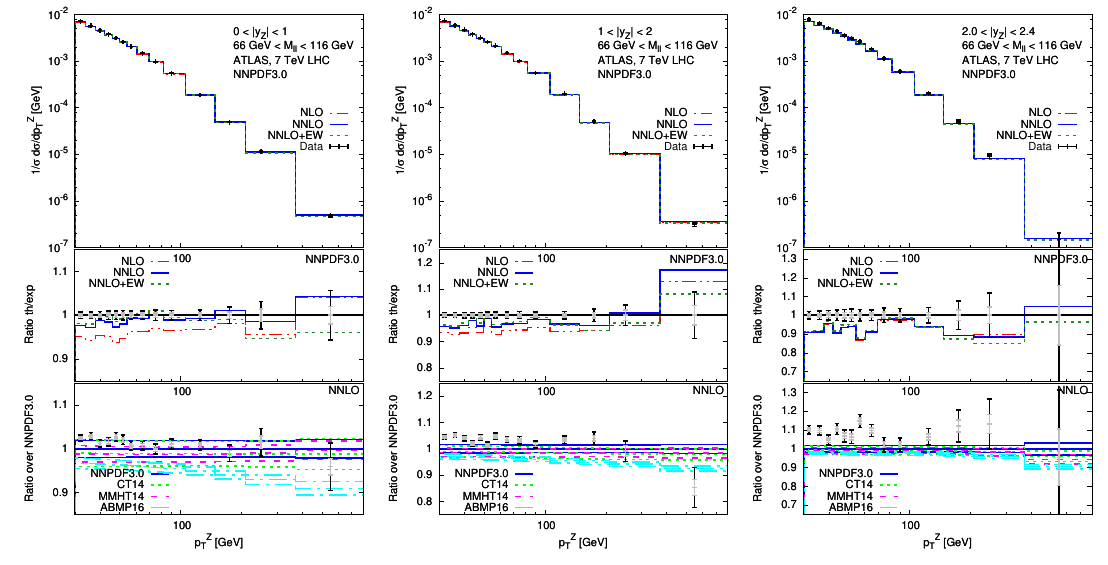
Figure 1 . Top inset: Theory-data comparison for the ATLAS 7 TeV data [14] using NLO (dashed red), NNLO (solid blue) and NNLO+EW(dot-dashed green) predictions. The NNPDF3.0 (N)NLO sets with (cid:11) s ( M Z ) = 0 : 118 are used for the (N)NLO predictions. Middle inset: NLO, NNLO and NNLO QCD + NLO EW predictions are divided by the experimental central value. The outer error bar (black) of the data points is given by the total experimental uncertainty, while the inner error bar (grey) is given by sum in quadrature of the bin-by-bin statistical and uncorrelated uncer- tainties. Third inset: the NNLO predictions computed with the CT14 (green dotted), MMHT2014 (pink dashed), ABMP16 (cyan dot-dashed) NNLO PDF sets are normalized to the NNLO predic- tions computed with the NNPDF3.0 (solid blue) PDF set. Error bands represent the 68% C.L. PDF